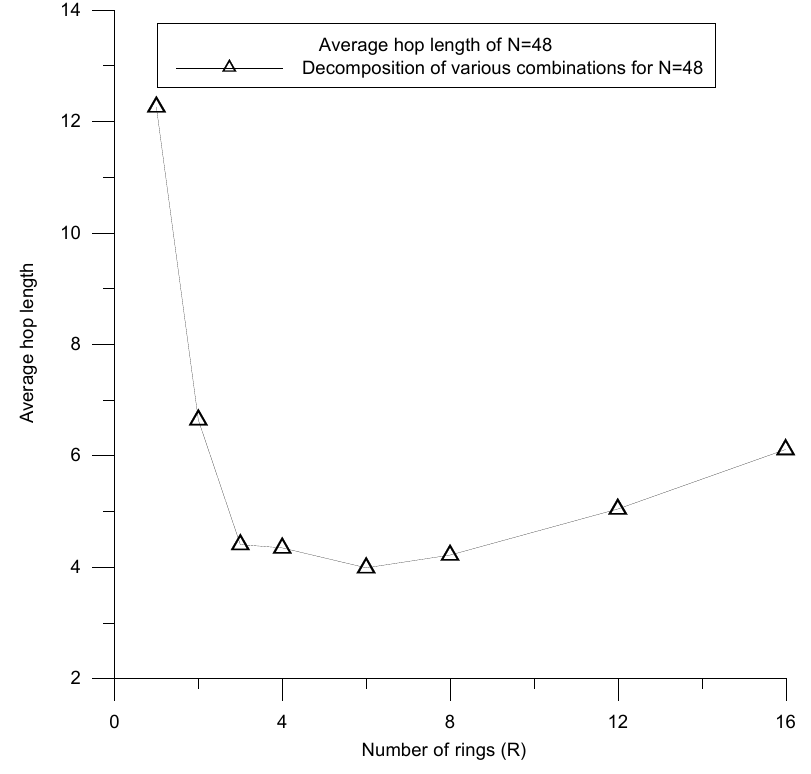
Figure 1. The average path length of N = 48 example.